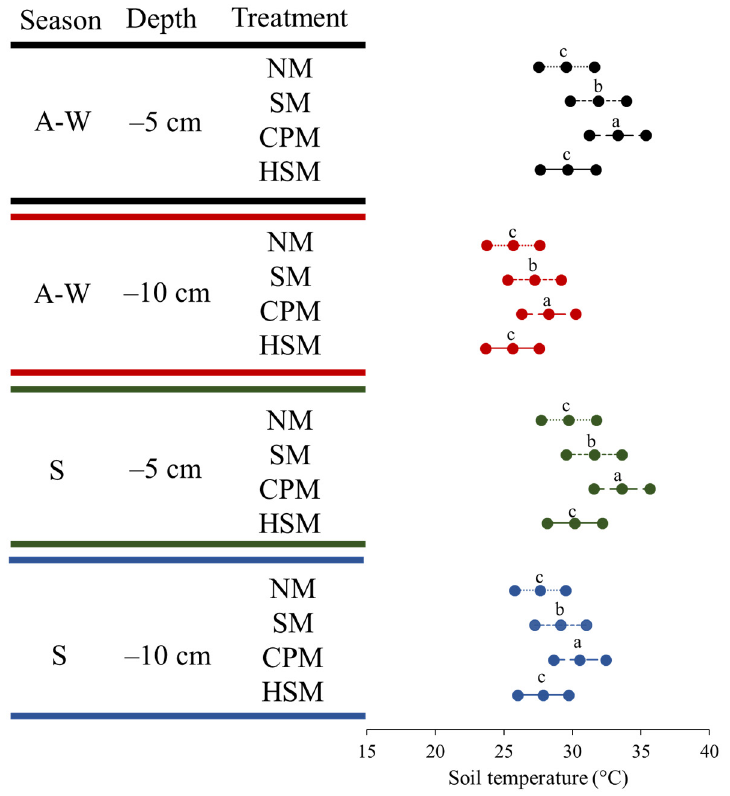
Figure 8. Average soil temperatures and relative 95% confidence intervals obtained in response to the different mulching treatments in the experiment by Ramakrishna et al. [150]. The values were grouped by season and measurement depth. Different letters within each season/depth indicate significant differences between treatments ( p ≤ 0.05). A–W: autumn-winter cycle; S: spring cycle; NM: no mulch; SM: straw mulch; CPM: conventional plastic mulch; HSM: hydrophilic sprayable